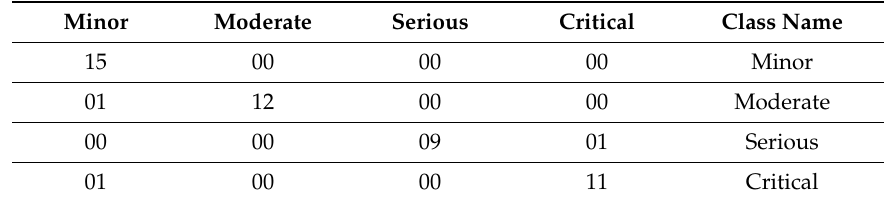
Table 9. Confusion Matrix for fold 2.